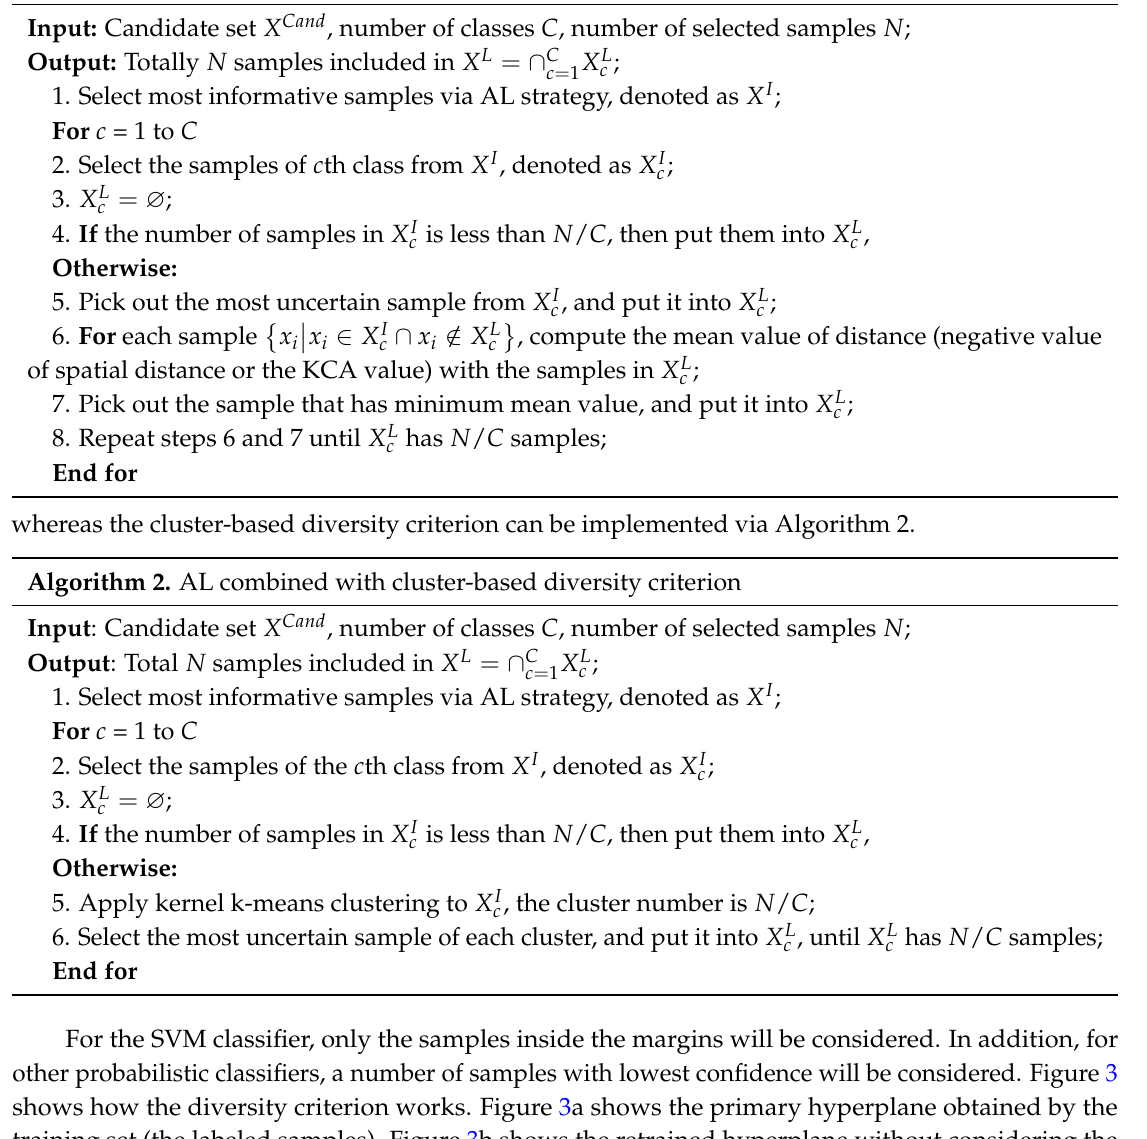
Algorithm 1. AL combined with similarity measure–based diversity criterion